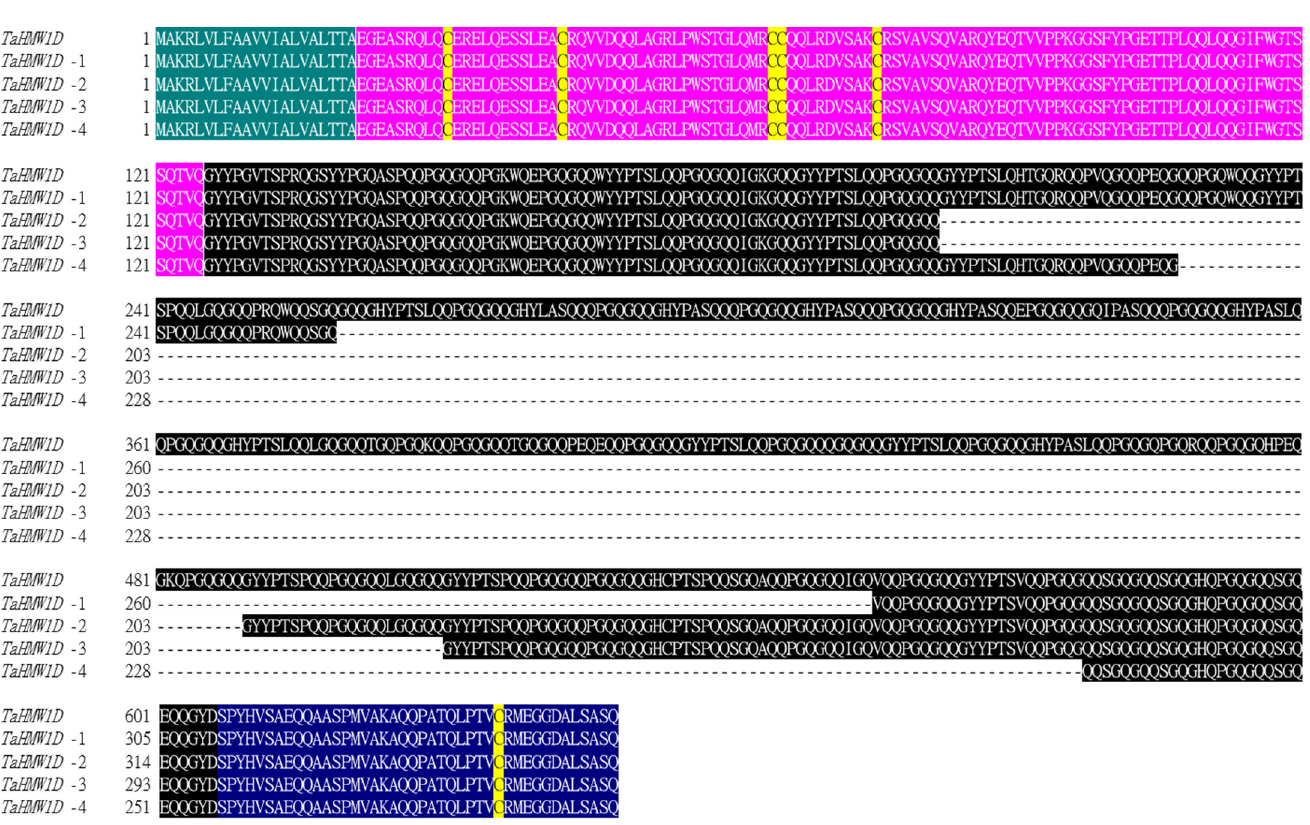
Figure 6. Conserved motif sequence alignments of TaHMW1D and its transcript variants in Keumgang . Motifs with identical sequences are given the same number. Signal peptide (1, 2), N-terminal region (3–8), C-terminal region (9–11). The region between motifs 8 and 9 is a repetitive sequence region in which deletion events occur.